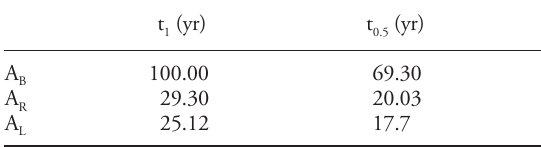
Table 1. Linear turnover time (t definitions of gap and the light gap area. The light gap area and A include the interior and the edge zones of the gap. Assumed R forest area = 6.9